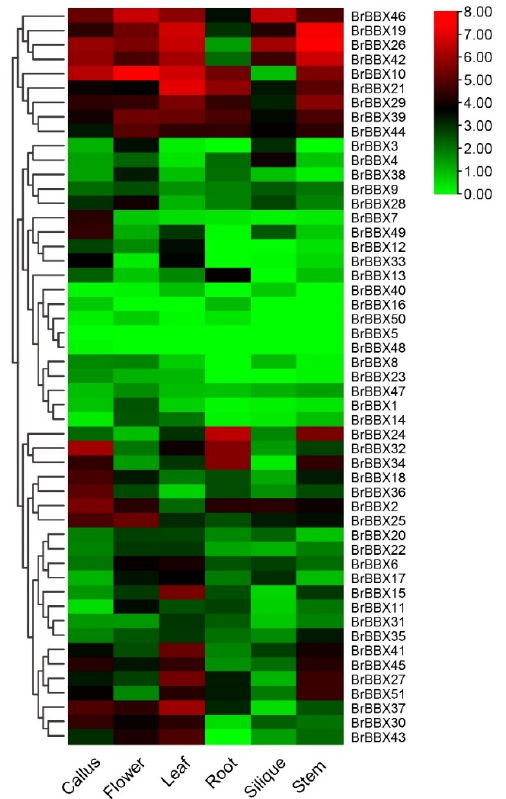
Figure 9. Tissue-specific BrBBX expression patterns. The relative expression data were log 2 -transformed using the pheatmap package of R. A cluster dendrogram is provided to the left of the heat map. Blue and red indicate downregulated and upregulated expression, respectively.